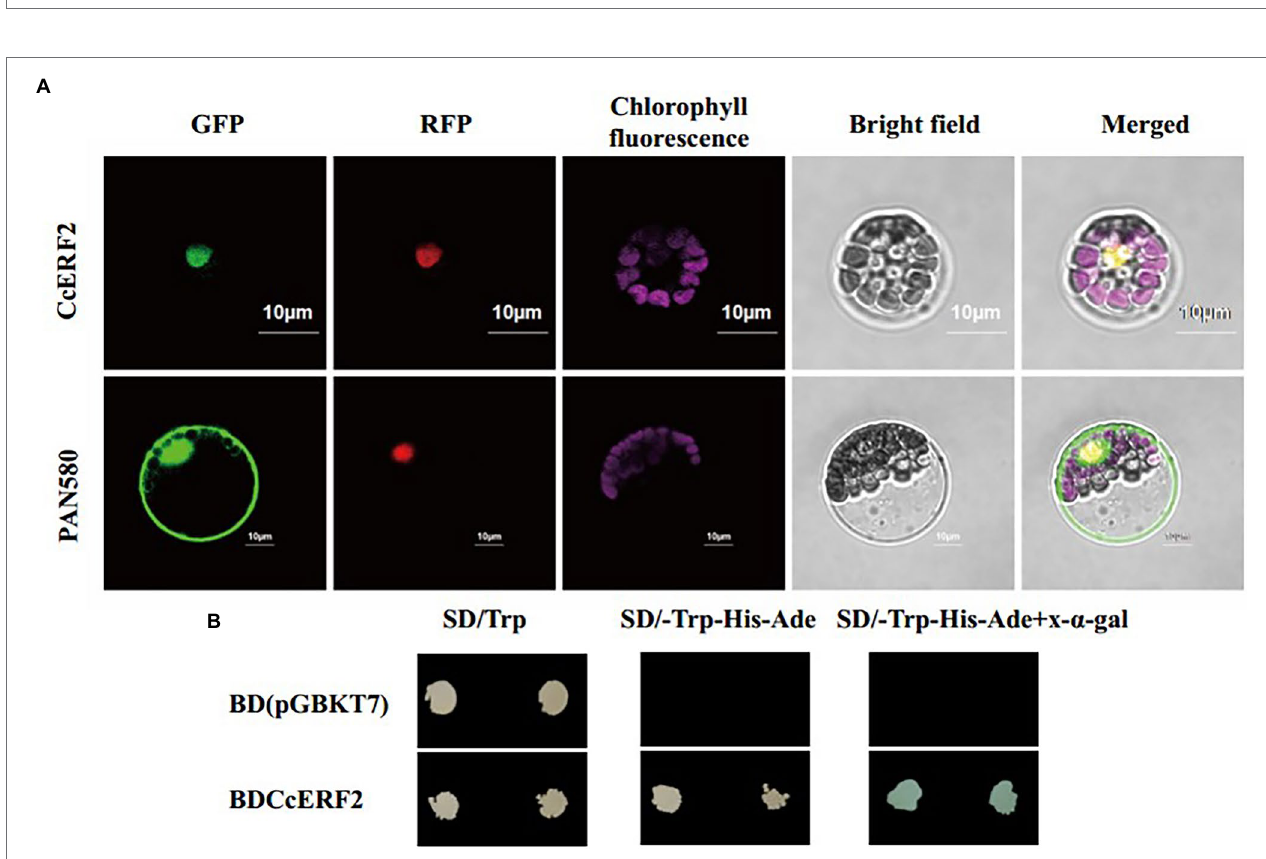
FIGURE 3 | Phylogenic tree of ERF transcription factors (TFs), analysis of promoter cis-acting elements and multiple amino acid sequence alignment of CcERF2 TFs. (A) Multiple amino acid sequence alignment of ERF2 TFs. (B) Promoter cis-acting elements comprising CcERF2 in Capsicum chinense and 47 ERF2 promoters in plant. (C) Phylogenetic tree comprising CcERF2 in C. chinense and 47 ERF2 TFs in plant.